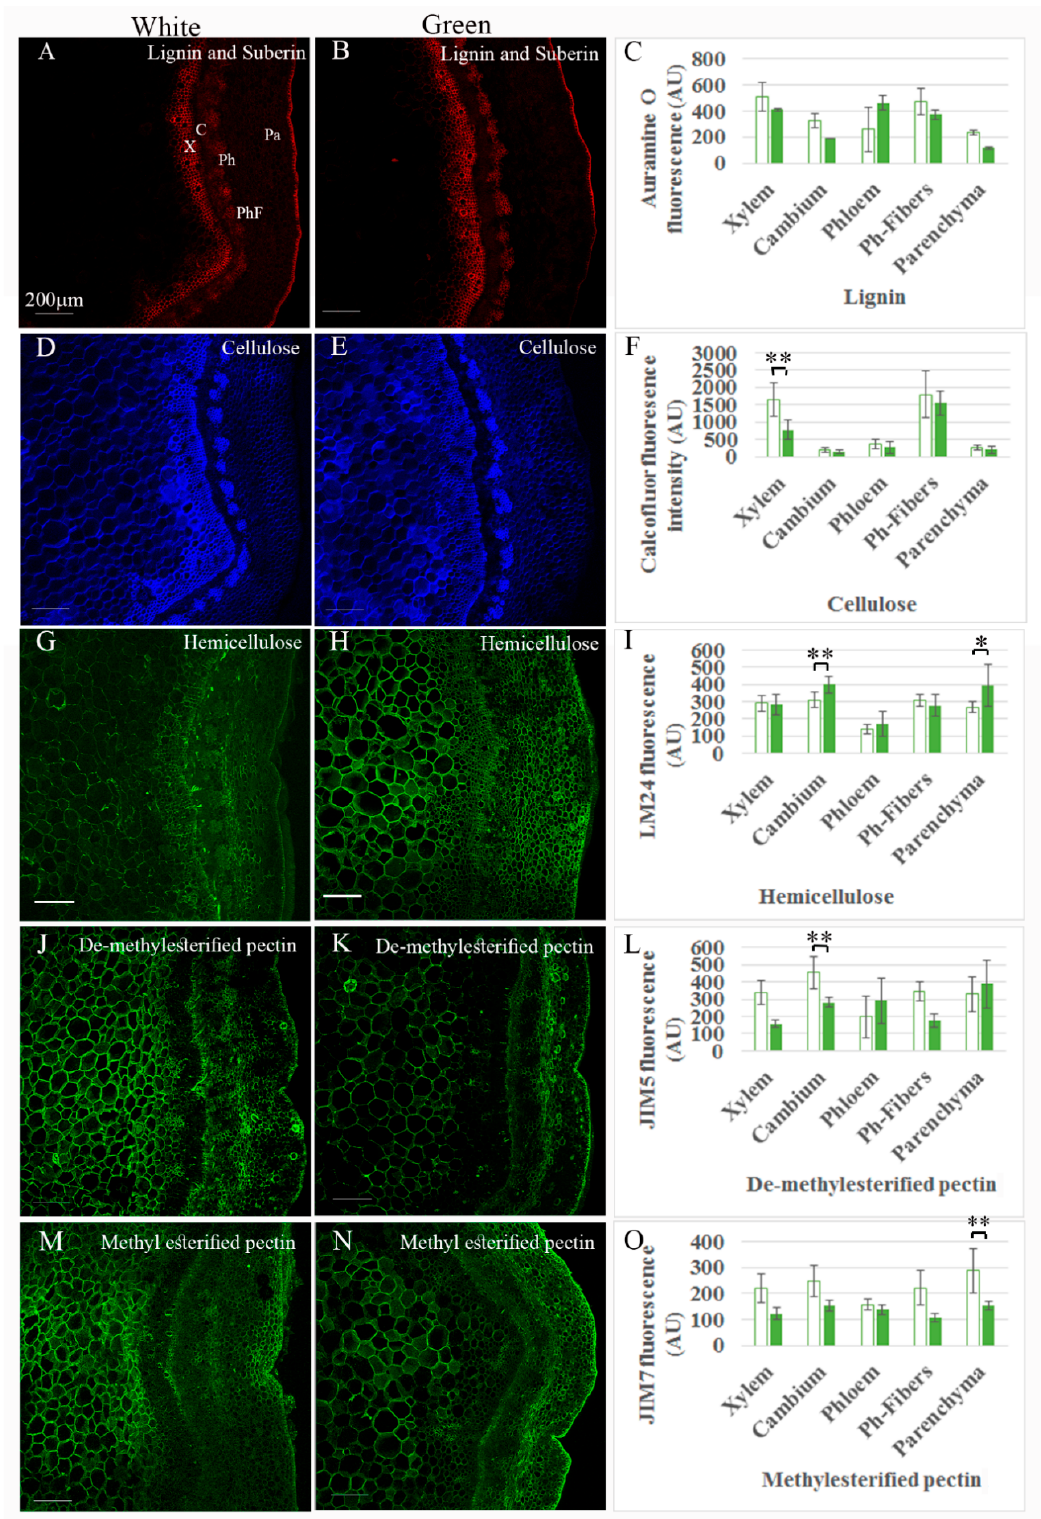
Figure 2. Fluorescence staining and measurements of fixed sections of the cutting bases. ( A – C ) Lignin and suberin staining by Auramine O. ( D – F ) Cellulose staining by calcofluor. ( G – I ) Hemicellulose staining with antibody LM24. ( J – L ) De-methylesterified pectin stained with antibody JIM5. ( M – O ) Methylesterified pectin stained with JIM7. * p < 0.05, ** p < 0.01 by Scheffe test. Scale bars are 200 µm. X—xylem, C—cambium, Ph—phloem, PhF—phloem fibers,